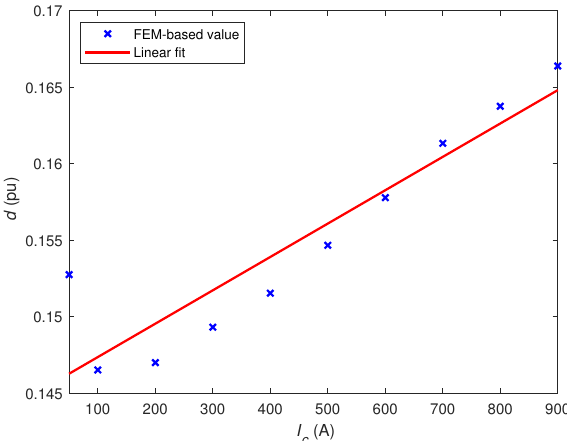
Figure 15. Estimation results for parameter d in Cable 1H.